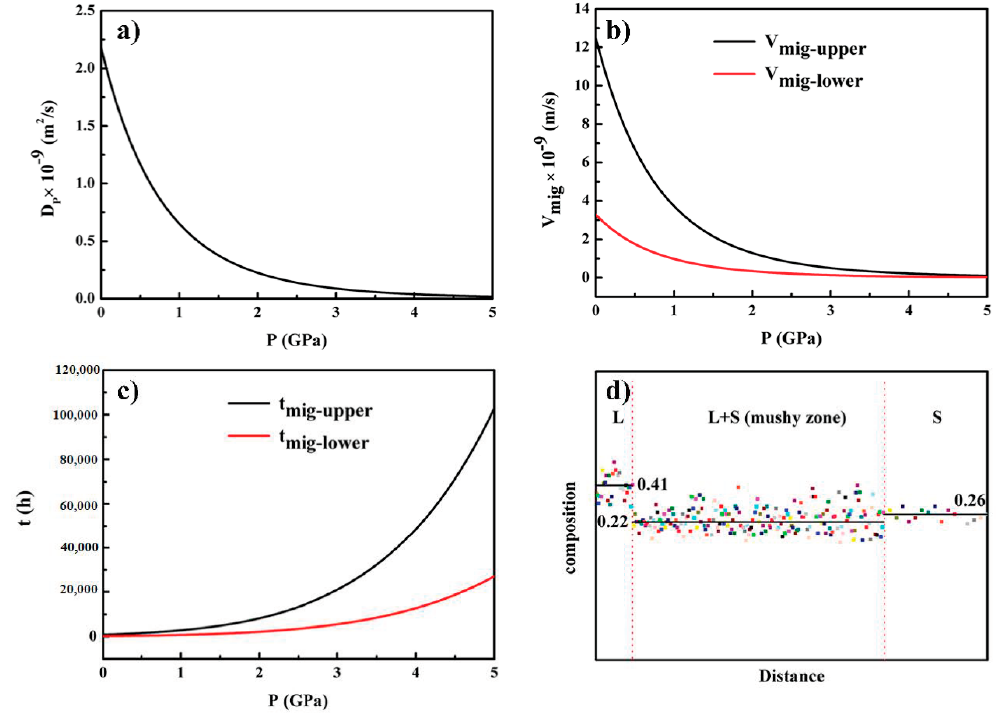
Figure 5. The effects of high pressure on ( a ) the coefficient of solute diffusion; ( b ) migration velocity of the liquid pool; ( c ) migration time of the liquid pool; ( d ) the content of Ni in the mushy zone.